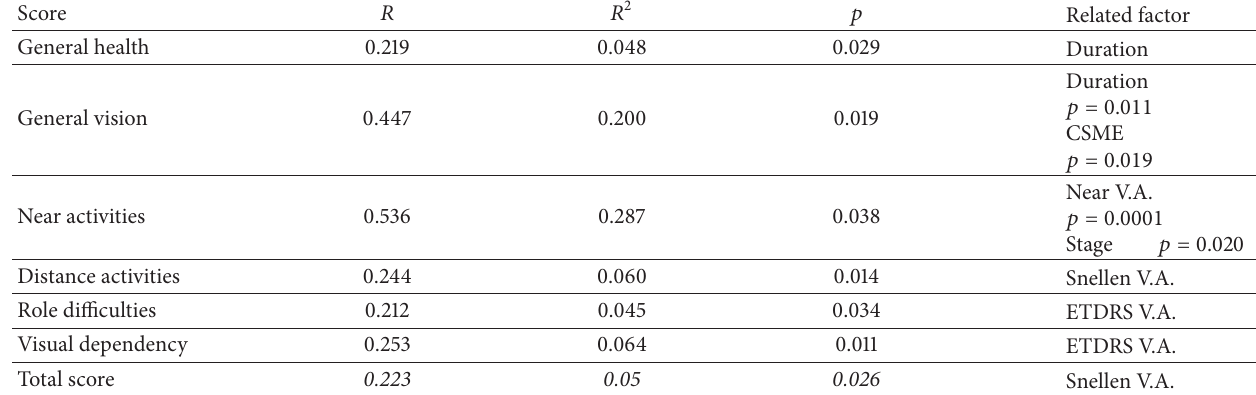
Table 9: Stepwise linear regression analysis of the questionnaire